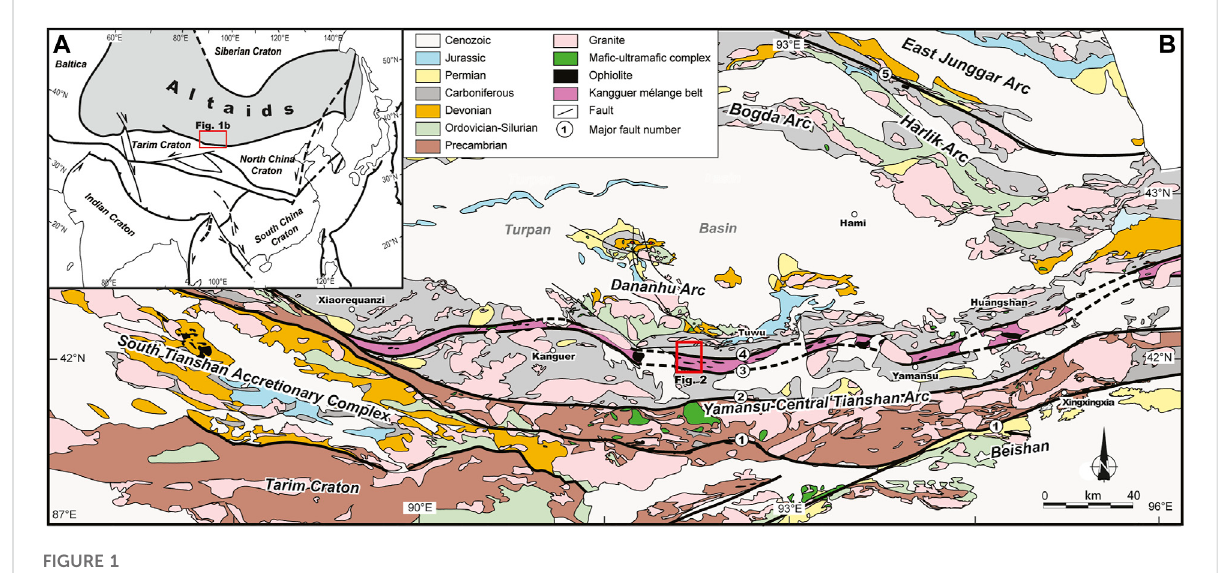
FIGURE 1 (A) Schematic tectonic map of Central Asia ( Ş engör et al., 1993; Xiao et al., 2018) showing the position of the eastern Tianshan in Figure 1B. (B) Geological map of the eastern Tianshan showing the distribution of the main tectonic units (modi fi ed after Xiao et al. (2004)). The locations of Figure 2 are marked. ① Kawabulake-Xingxingxia fault, ② Aqikekuduke-Shaquanzi fault, ③ Yamansu-Kushui fault, ④ Kanguer fault, and ⑤ Kalameili